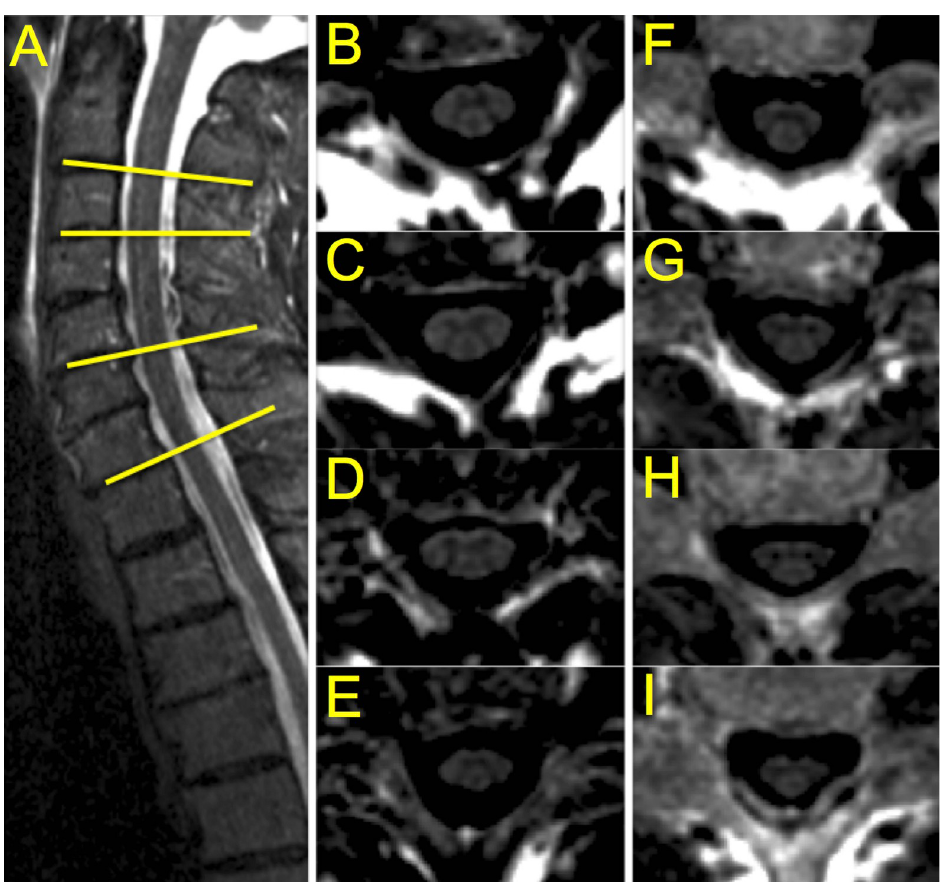
Fig 1. Illustration of PSIR acquisition on two motor neuron disease patients. A) Sagittal short tau inversion recovery (STIR) image used to prescribe the PSIR acquisitions at the four cervical disc levels (yellow lines). B-E) PSIR acquisitions (phase-sensitive reconstructed images are shown) of a patient with predominantly bulbar symptoms at C2-C3, C3-C4, C5-C6 and C7-T1 disc level, respectively; F-I) PSIR acquisitions of the patient with PLS at C2-C3, C3-C4, C5-C6 and C7-T1 disc level, respectively. Notice how gray and white matter are visibly reduced at all four levels in the PLS patient when compared with the patient with bulbar